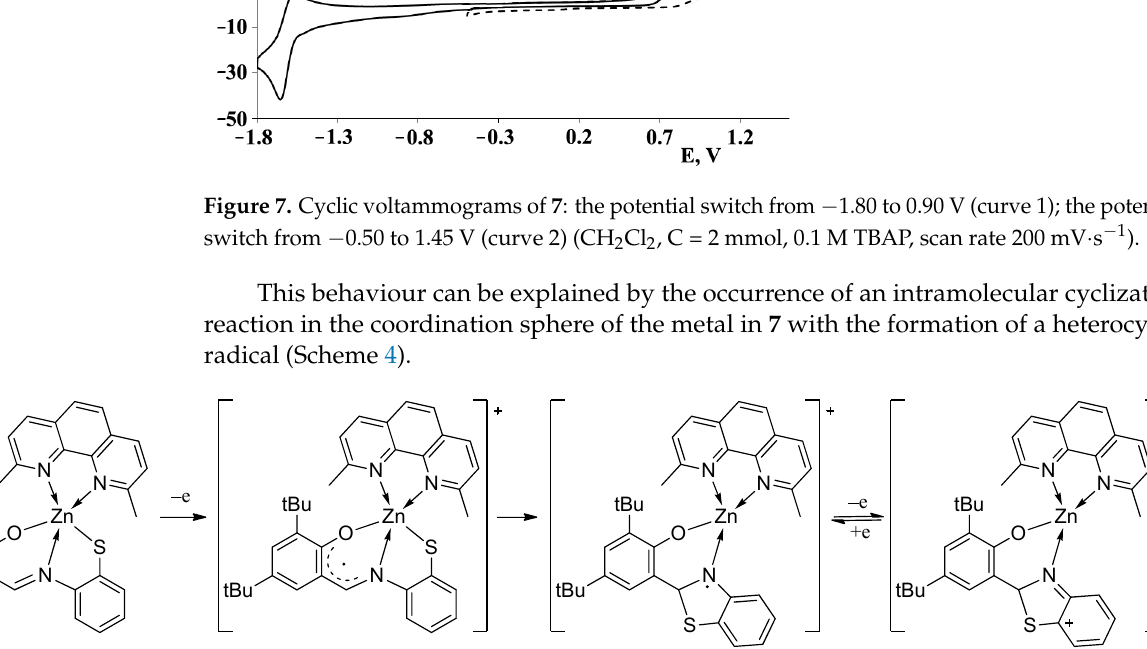
Scheme 4. Two electrochemical oxidation of 7 with the intramolecular cyclization stage.